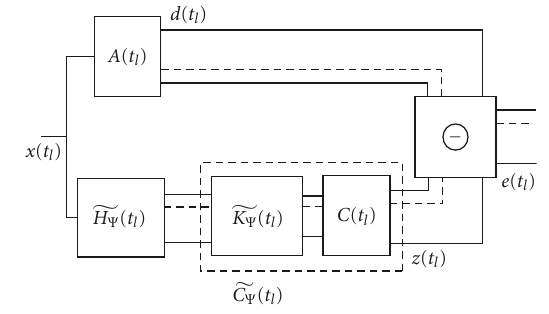
Figure 8: Block diagram of the modified inverse filtering